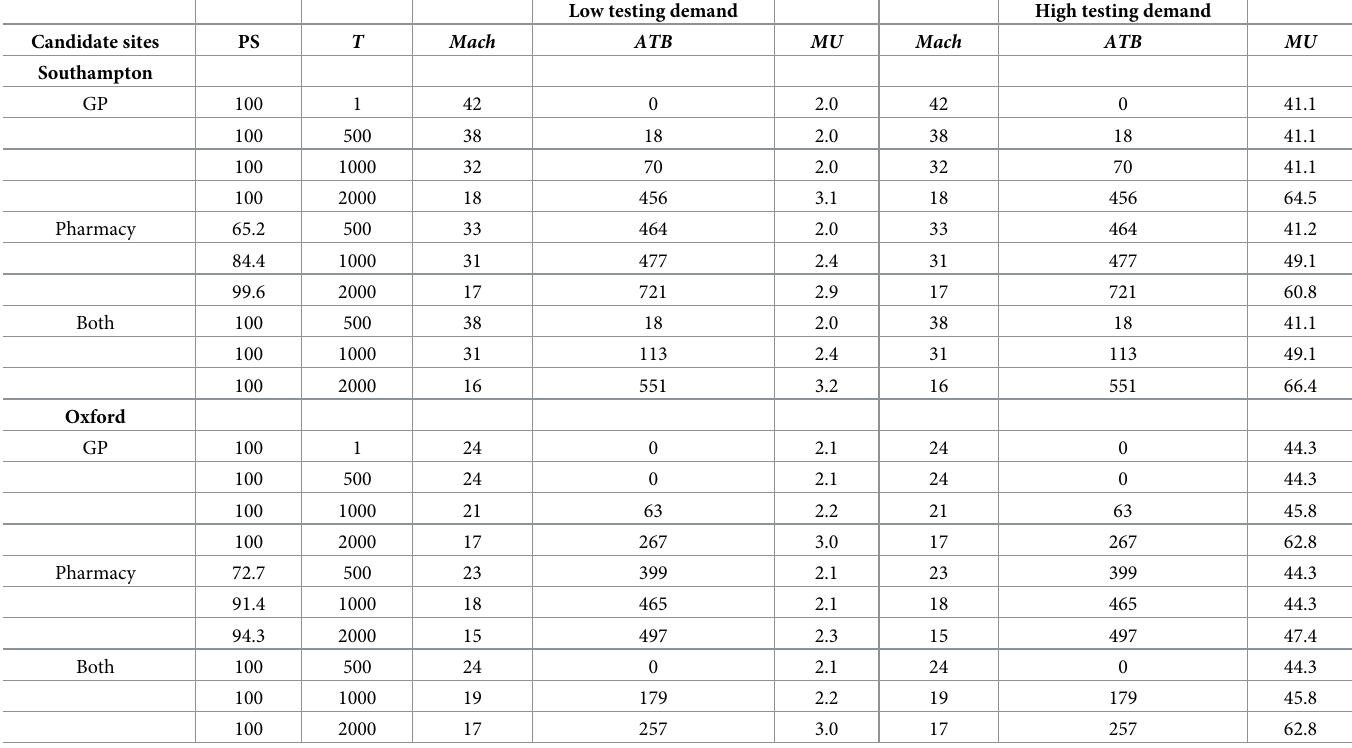
Fig 2 illustrates the required number of machines per 100,000 inhabitants and the average travel burden for patients, for a scenario with high testing demand and using both GP surger- ies and pharmacies as candidate locations. For the same patient travel burden, rural areas need more testing facilities per person than urban areas. Average travel burden tends to be signifi- cantly lower than the travel limits, as there would be only a limited number of patients are assigned to testing facilities significantly far from their usual GP surgeries. Table 3. Model results for urban areas. PS is the percentage of patients that can be served with the proposed maximum travel burden, T is the maximum travel burden allowed, Mach is the number of required testing machines, ATB is the average travel burden for the patients (m) and MU (%) is the highest capacity utilisation observed across all opened facilities, measured as the expected tests over the testing capacity of that